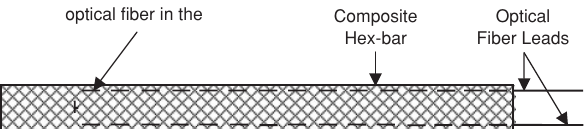
Figure 4 Hex-bar geometry. optical fiber in the